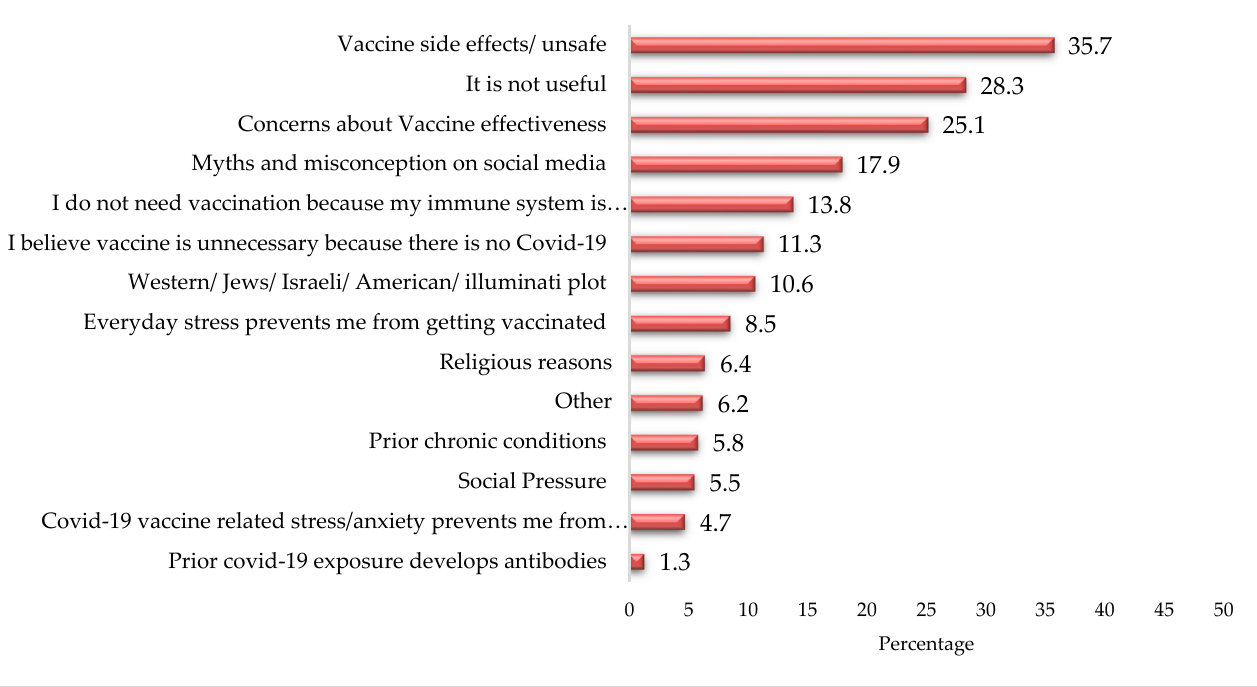
Figure 4. Factors discouraging getting vaccination (%).